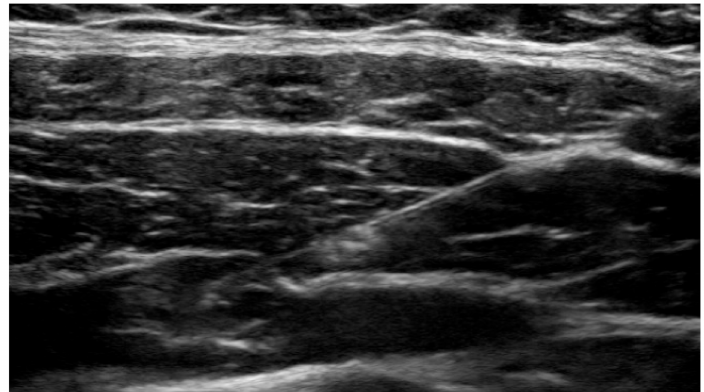
Figure 1. Ultrasound guided transversus abdominis plane